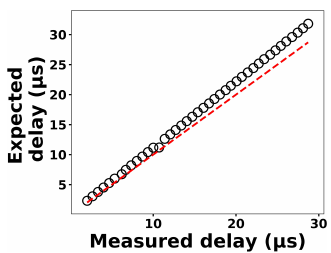
Figure 4. The expected delay set by the Arduino board as a function of the measured delay.